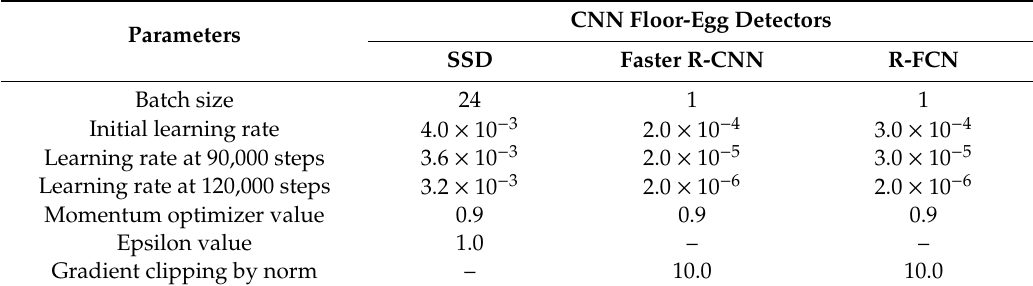
Table 2. Configuration for training the Convolutional Neural Network (CNN) floor-egg detectors. Parameters